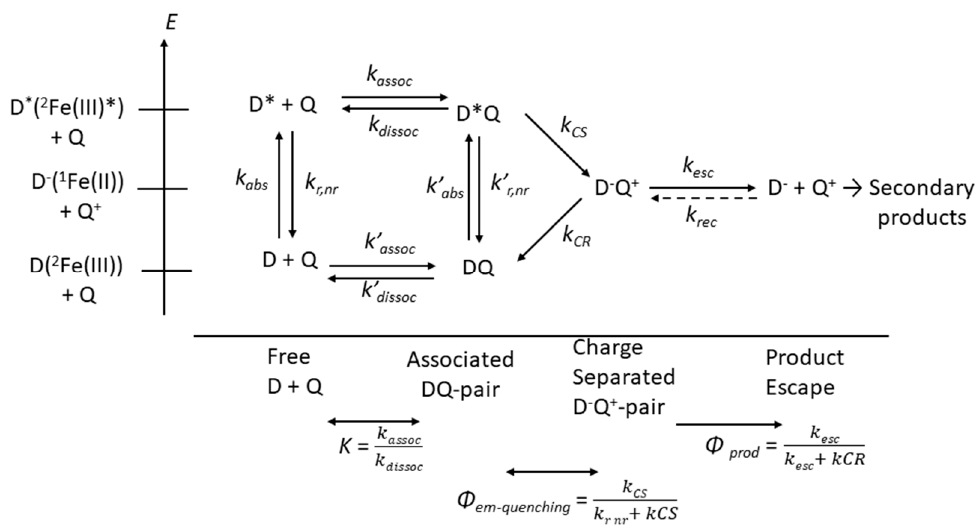
Figure 16. Photoinduced bimolecular kinetics involving the unconventional photoexcited 2 LMCT state of a Fe(III)NHC complex. From left to right, the scheme illustrates photo-excitation of the light-harvesting complex, formation of a donor-acceptor pair involving the excited complex, followed by charge separation (CS) as well as charge recombination (CR), in competition with the ultimate long-lived photoproduct formation associated with solvent cage escape. This illustrates a case of oxidation and subsequent re-reduction or photoproduct formation of a sacrificial electron donor that gives a full photocycle, in which all steps are overall doublet states without any intersystem crossing or spin forbidden transitions.